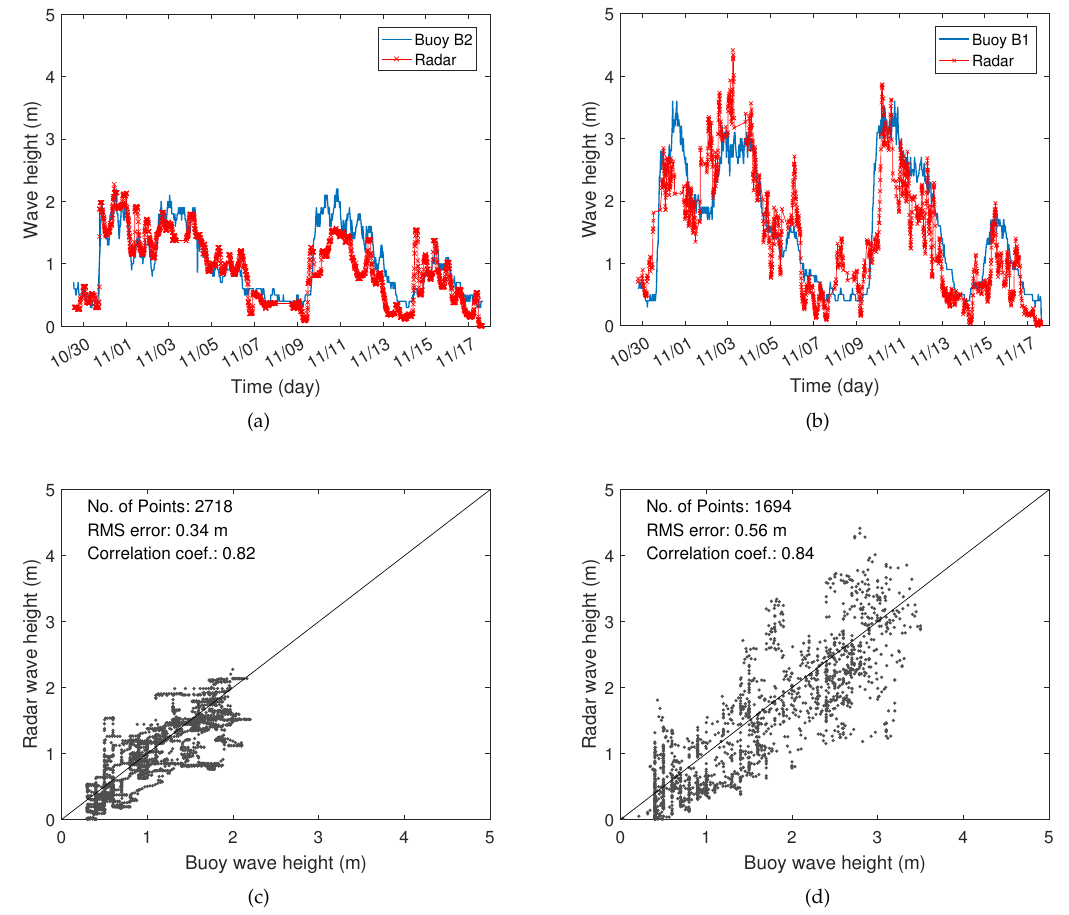
Figure 10. Wave height comparison between dual-frequency radar (red dots) and buoys (blue lines): temporal sequence at ( a ) 15 km and ( b ) 70 km, and scatter plot at ( c ) 15 km and ( d ) 70 km.